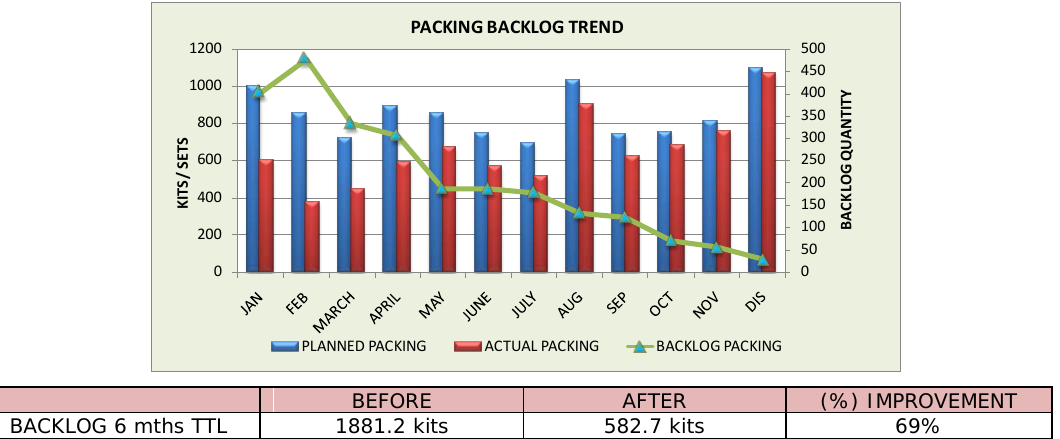
Figure 9C. “Percentage of improvement for packing